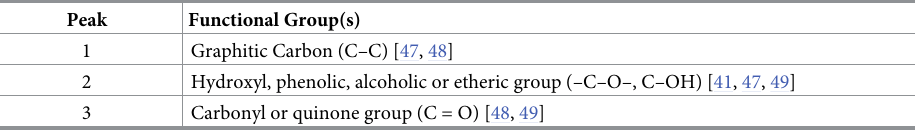
Table 4. The XPS identified functional groups corresponding to Fig